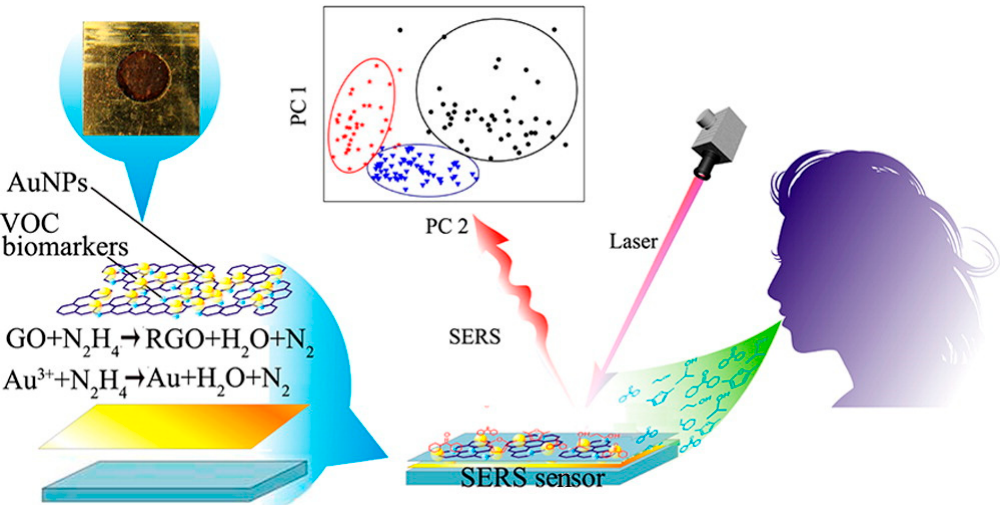
Figure 2. Schematic diagrams of a SERS sensor and overview of the processes involved in the use of breath for the determination of early gastric cancer (EGC) and advanced gastric cancer (AGC). AuNPs, gold nanoparticles; VOCs, volatile organic compounds; RGO, reduced graphene oxide; GO, graphene oxide; PC, principal component analysis. (Reproduced with permission from [61]. Copyright 2016,